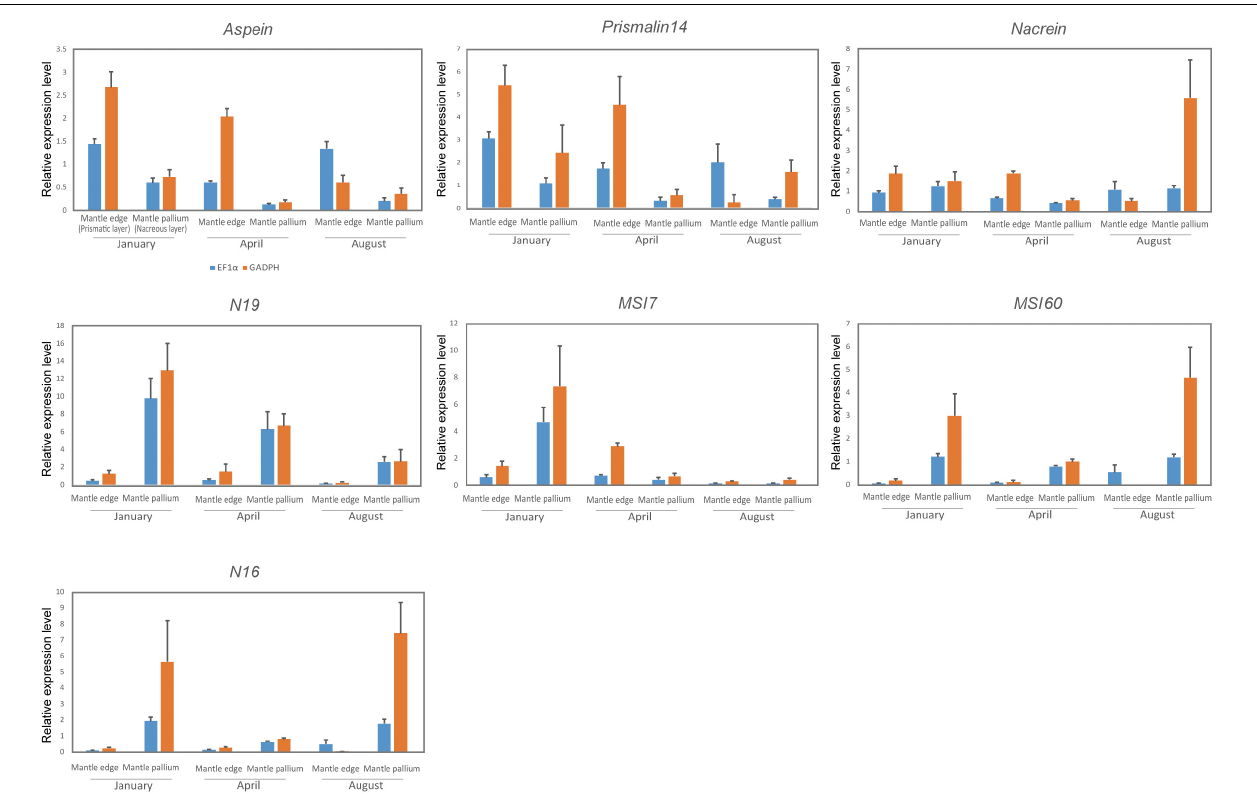
FIGURE 6 | Relative gene expression of biomineralization-related shell matrix genes normalized by housekeeping genes (blue, EF1 α ; orange, GAPDH ). Each value represents the mean ± SD of the data analyzed on up to five